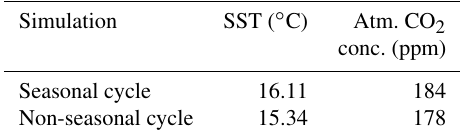
Table E1. Sea surface temperature ( ◦ C) and atmospheric CO 2 con- centration (ppm) for simulations with and without a seasonal cycle.